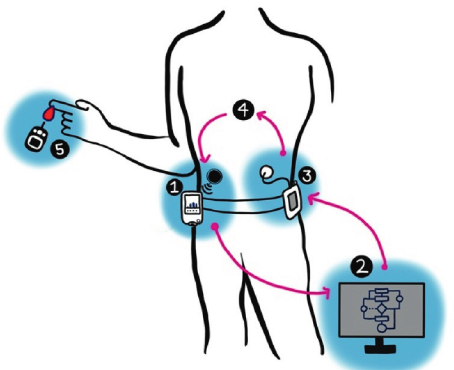
Figure 1: Artificial pancreas device system with four parts: (1) continuous glucose monitor (CGM); (2) APDS computer-con- trolled algorithm; (3) infusion pump; (4) the patient; (5) Blood glucose devices (BGDs) are used to calibrate the CGM (this figure is modified from